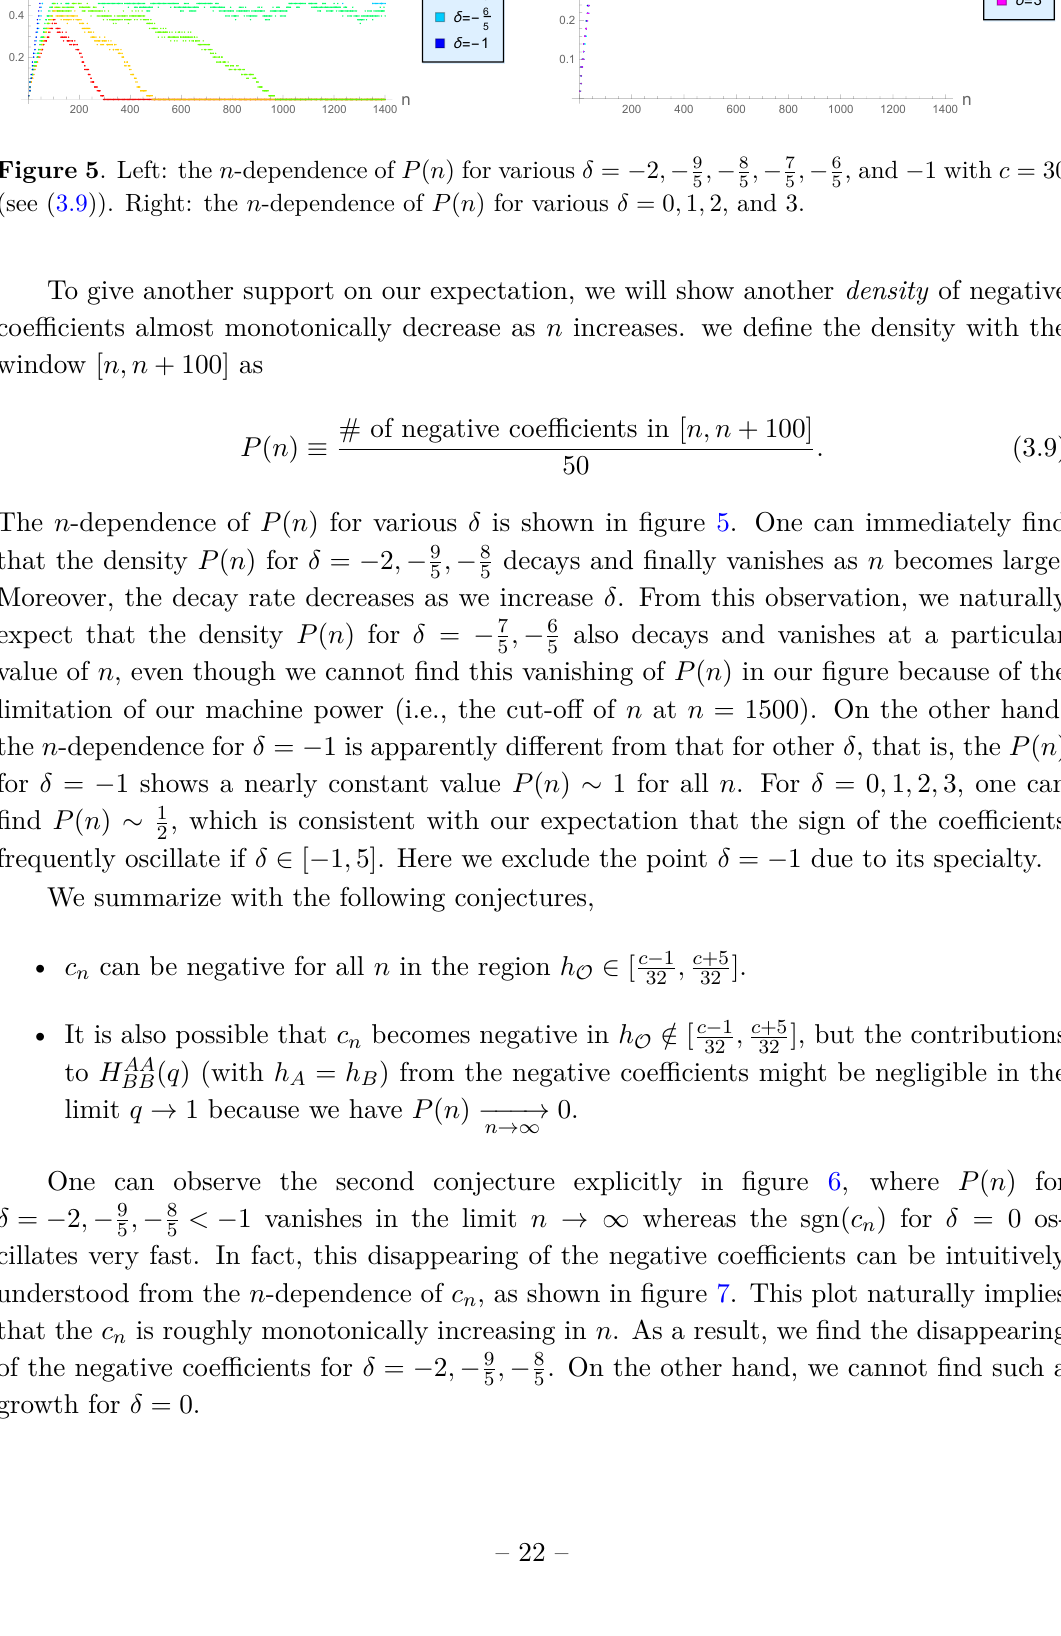
, and − 1 with c = 30 , − 8 , − 7 , − 6 5 5 5 5